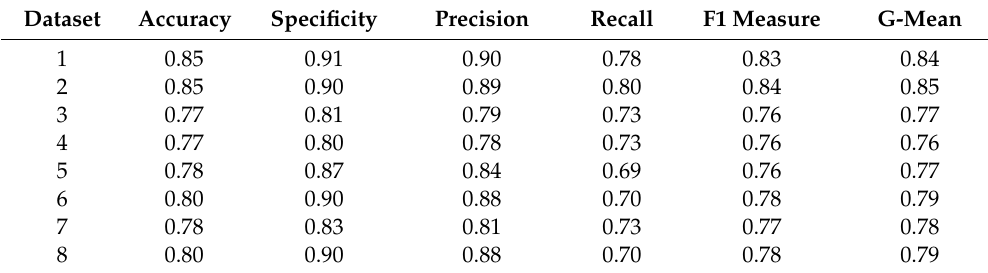
Figure 7. Optimization of hyperparameters box and sigma. Table 3. Results for